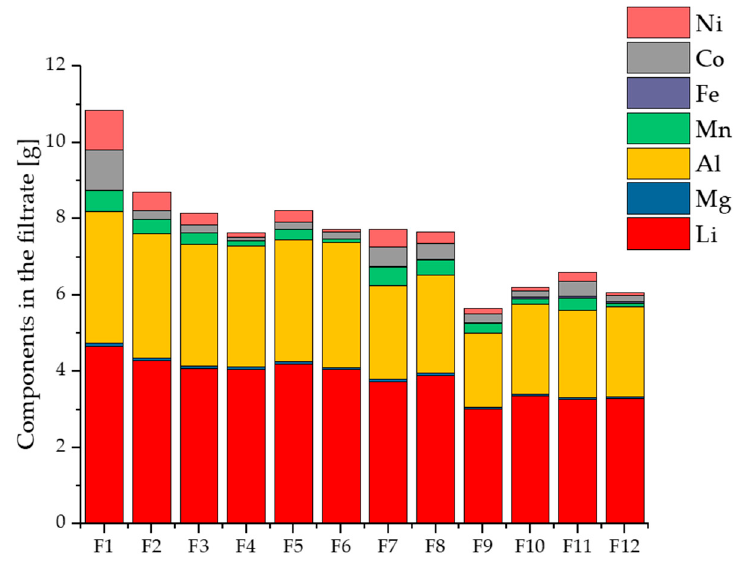
Figure 5. Compositions of the filtrate after precipitation with oxalic acid.